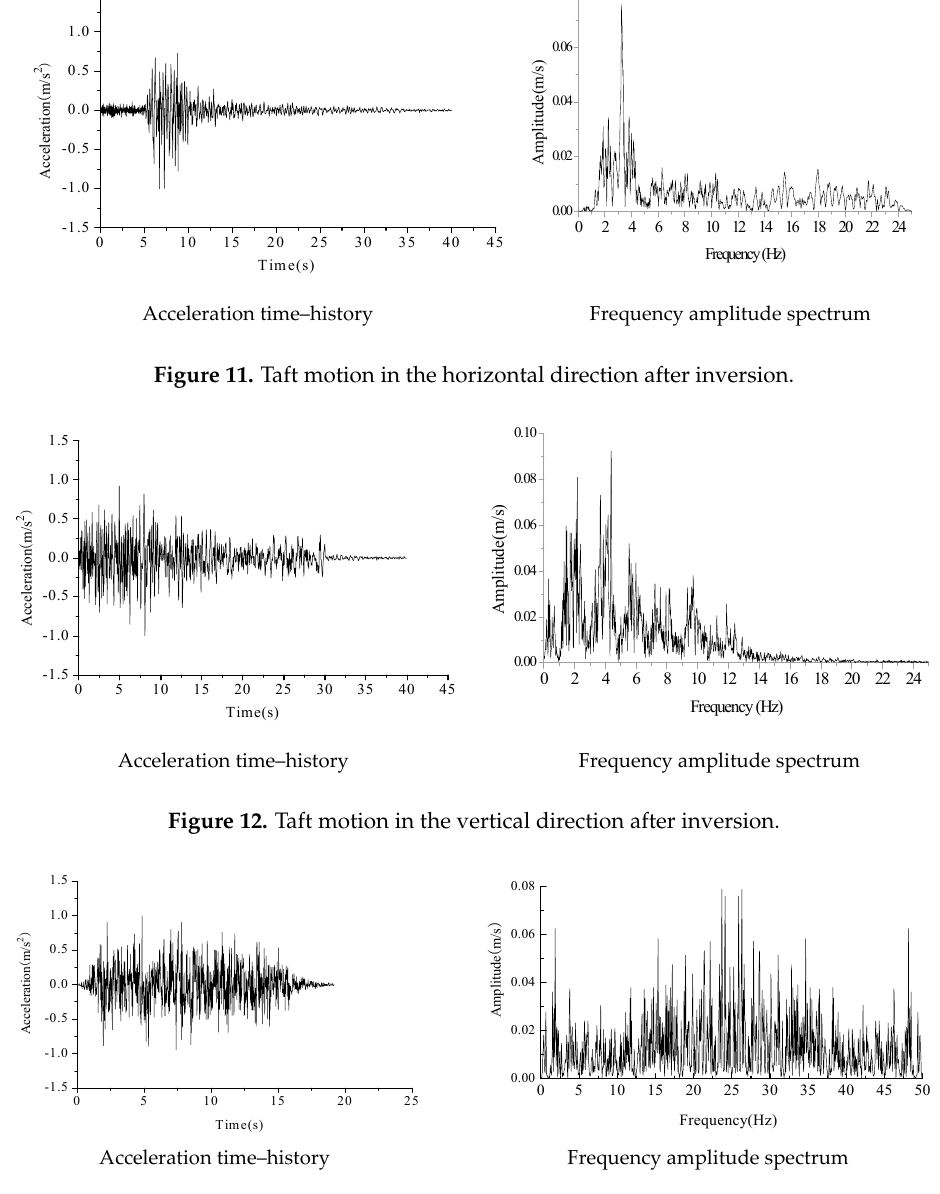
Figure 13. Lanzhou motion in the horizontal direction after inversion.